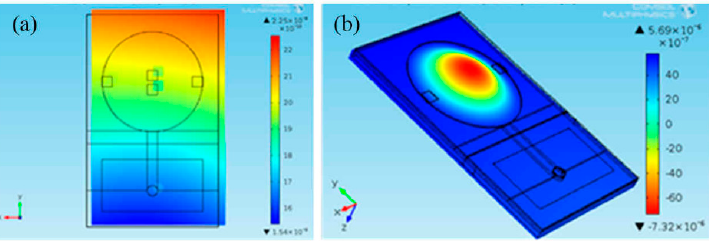
Figure 6. FEA predictions: ( a ) Simulated TCE-mismatch-induced displacement of the unloaded LTCC sensor structure glued in the housing by using adhesive A; ( b ) the sensor at 100 mbar pressure load.